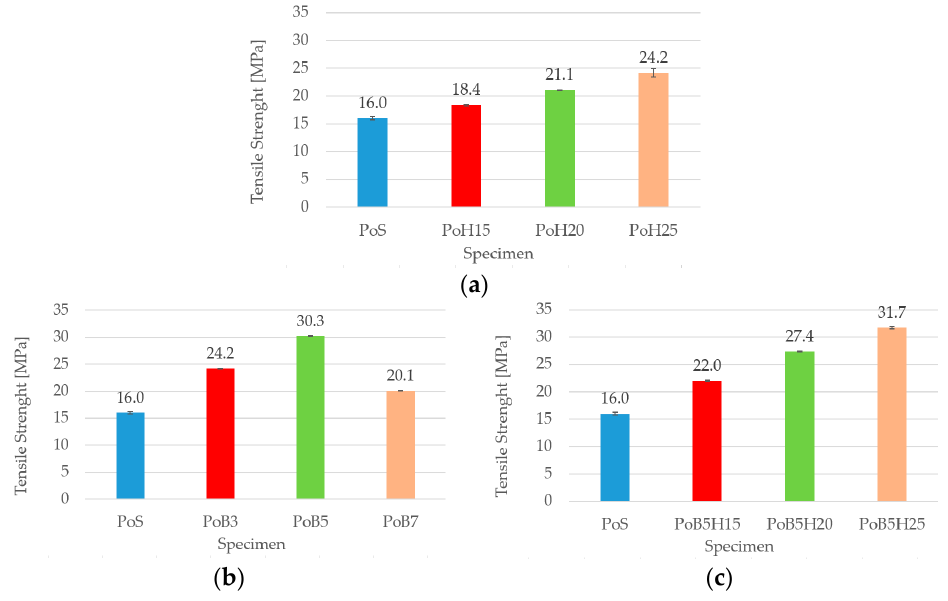
Figure 6. Tensile strength results. ( a ) Polymer/henequen composites (15, 20, and 25%); ( b ) polymer plus (3, 5, and 7%) of bentonite; ( c ) polymer plus 15% henequen and 5% of bentonite; polymer plus 20% henequen and 5% of bentonite; and polymer plus 25% henequen and 5% of bentonite.